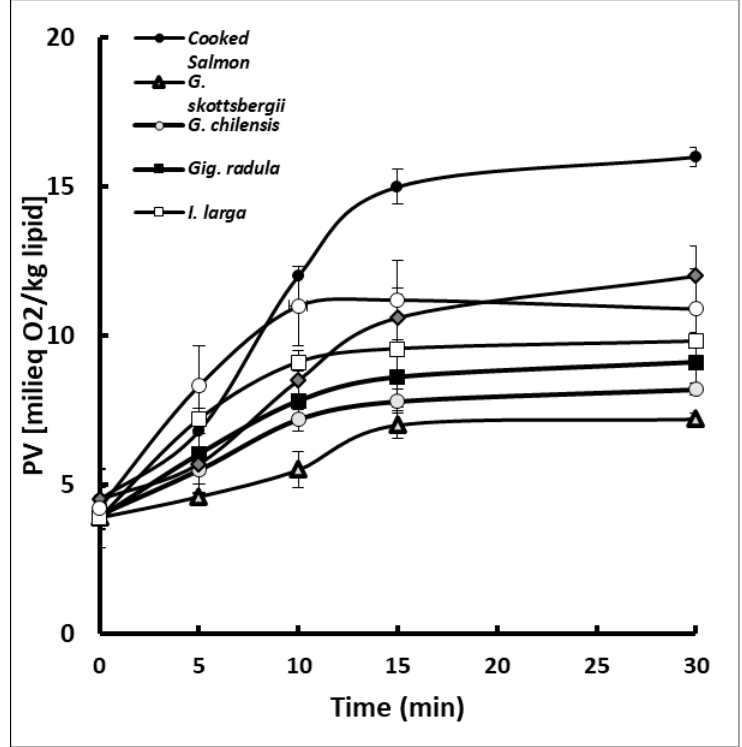
Figure 2. Inhibition of PV formation during cooking of salmon paste samples added with different extracts of red algae. Values are expressed as means ( n = 3) ± standard deviation.